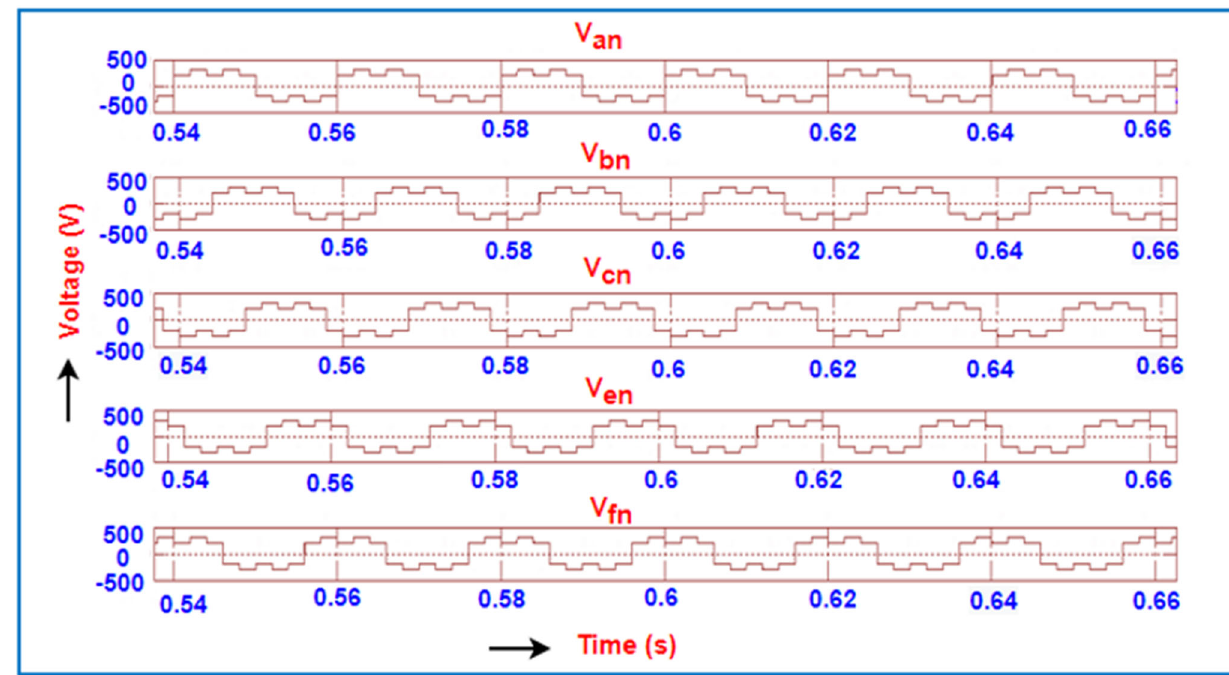
Figure 3. Five ‐ phase inverter—phase voltage. Figure 3. Five-phase inverter—phase